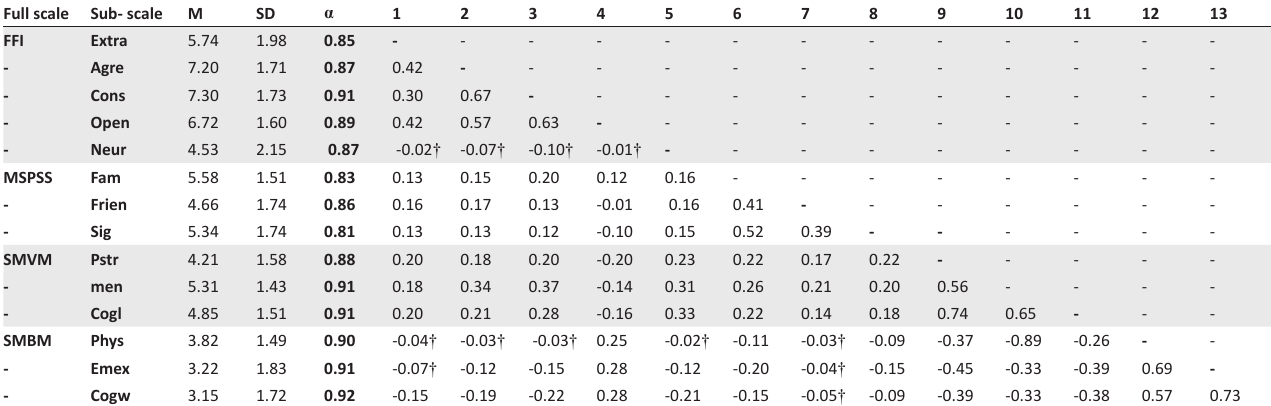
TABLE 1: Descriptive statistics, Chronbach alpha coefficients and correlation coefficients of the full and sub-scales used in the empirical study. Full scale Sub- scale M